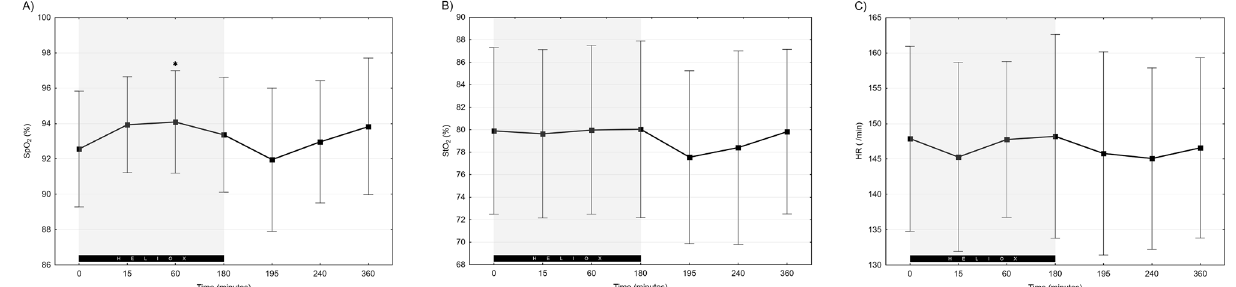
Figure 1. Values of SpO 2 ( A ), B) StO 2 ( B ) and HR ( C ) during the study. Grey background highlights heliox NIV-NAVA period. Data presented as mean ± SD; *indicates statistically significant changes versus